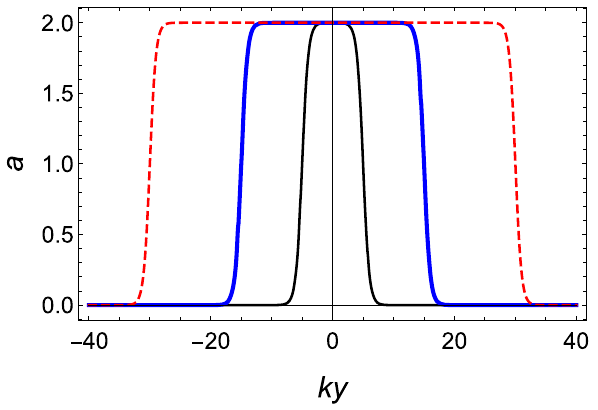
Fig. 4 Plotoftherange(thedarkregion)of k 2 α and kb inthecondition of f R > 0 for model 2